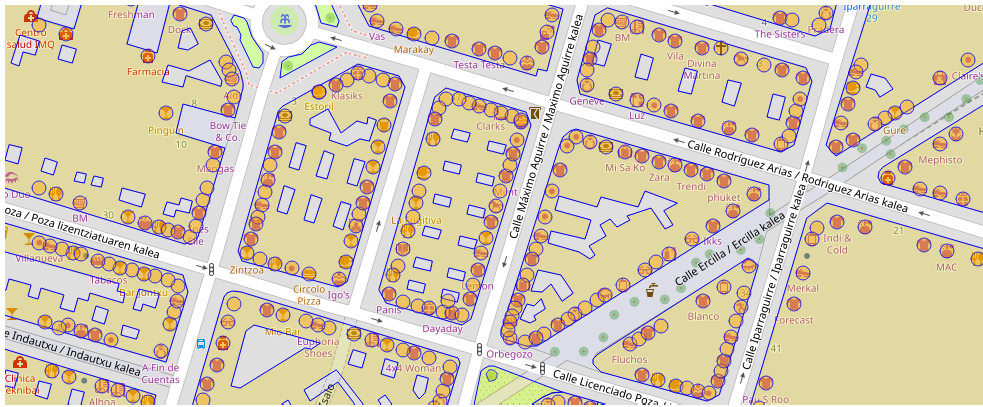
Figure 12. Example of the data that can be retrieved from Overpass API.